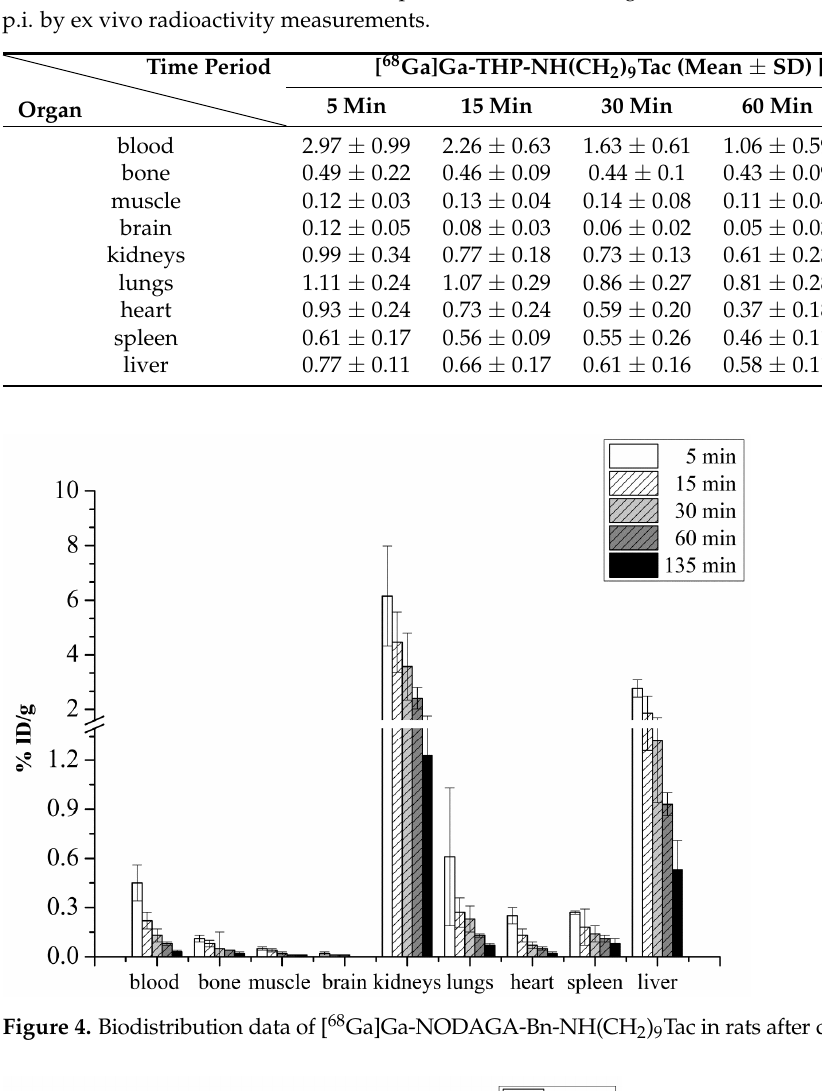
Table 3. [ 68 Ga]Ga-THP-NH(CH 2 ) 9 Tac uptake in selected rat organs determined after different time